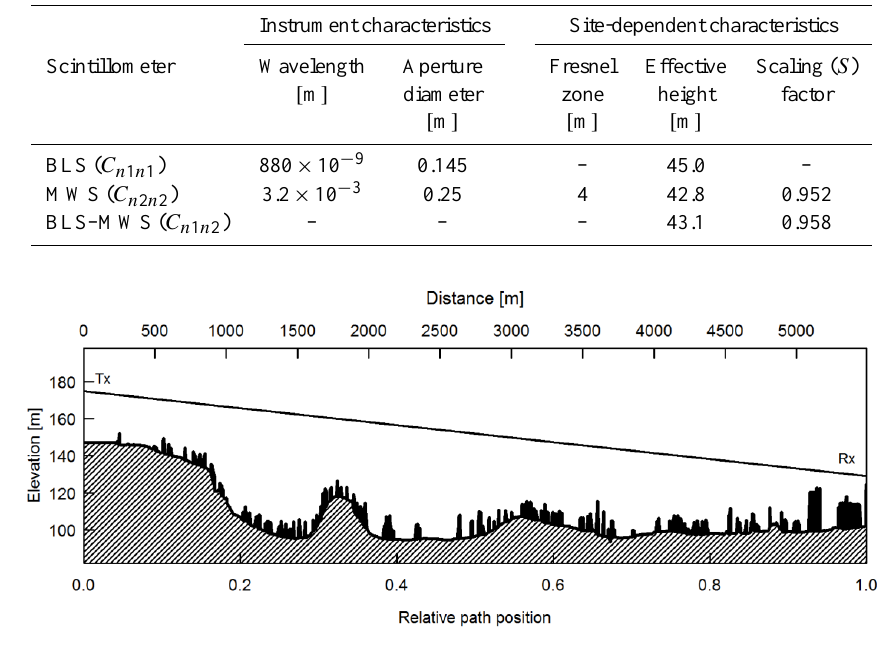
Figure 2. Cross-section of the land surface (metres above sea level) and height of obstacles (buildings and trees) along the BLS–MWS path. Tx denotes transmitter, Rx receiver.